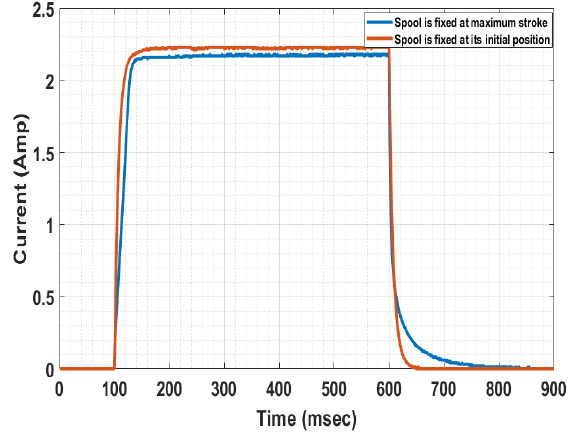
Figure 6. The current is measured when the valve spool is fixed at its initial position and when it is fixed at its maximum stroke position.